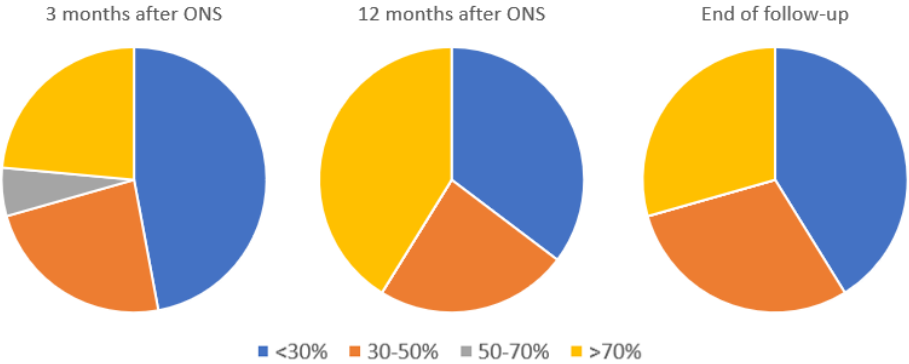
Figure 3. Overall improvement perceived by patients after occipital nerve stimulation (ONS) surgery. N = 17 (no missing values between the groups).